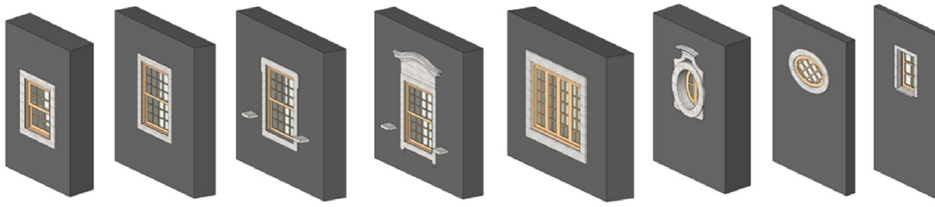
Figure 20. New library of distinct window families.